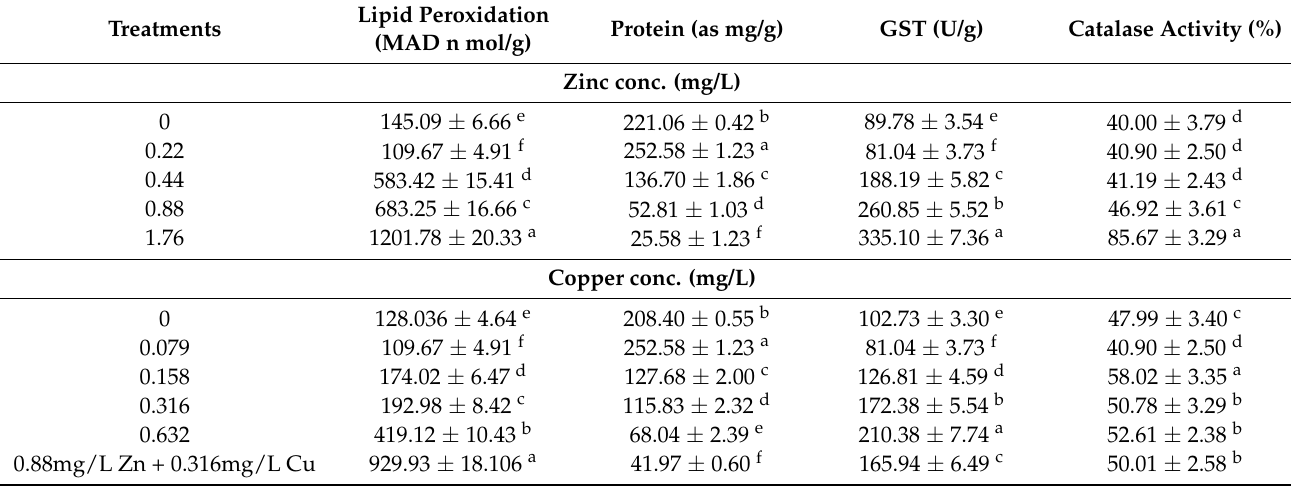
Table 11. Lipid peroxidation (MAD nmol/g), protein (mg/g), glutathione-S-transferase (U/g tissue), and catalase activity (%) generated by Nostoc linckia grown under various copper and zinc concentrations (separately or in combination). Treatments